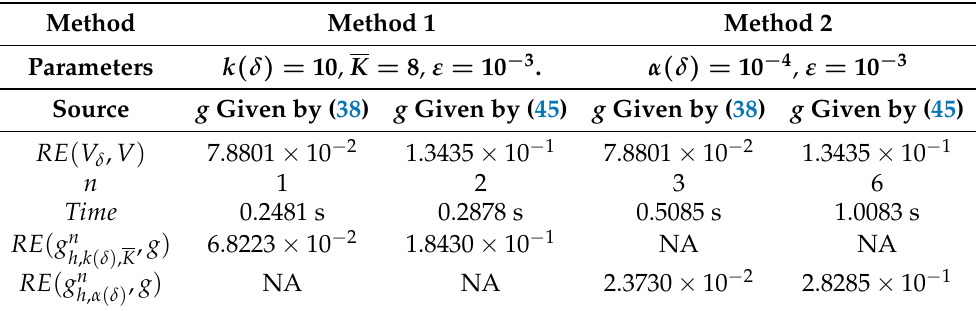
Table 5. Numerical results applying methods 1 and 2 for circular region with noisy data V δ for δ = 0.1, using mesh M 1 ( 774,1470 ) , and with the same measurement with error V δ for each source. NA means not applicable.